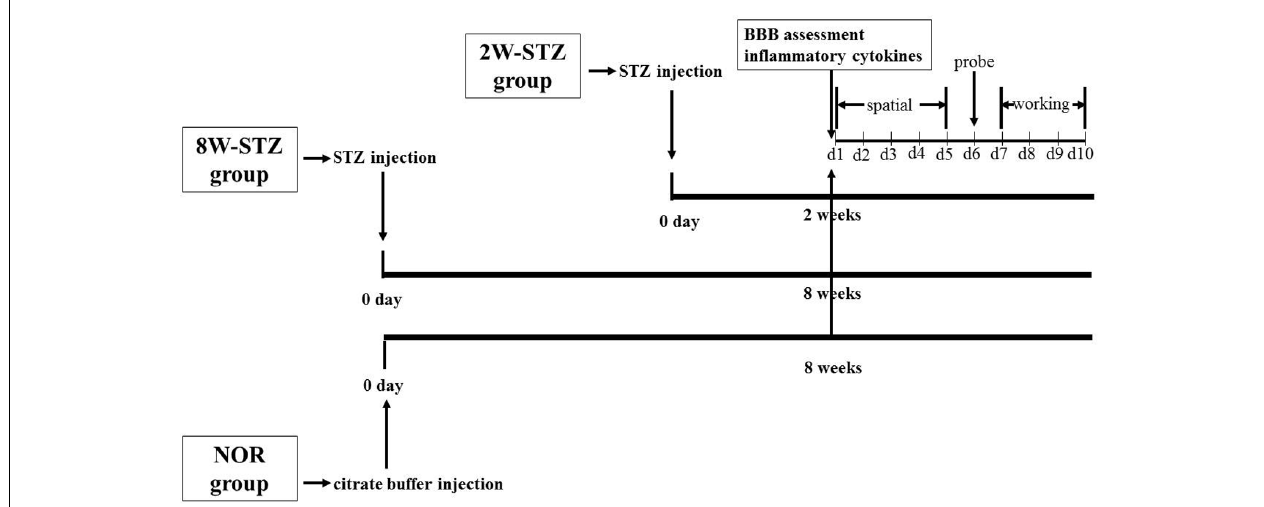
FIGURE 1 | Experimental design. Diabetic models were induced by single injection of streptozotocin on day 0. In the 2-week STZ group, the cognitive assessments were started at 2 weeks after STZ injection. The spatial acquisition trials over the first five consecutive days were followed by probe test on day 6 and working memory test from day 7 to day 10. In the 8-week STZ group, the same cognitive assessments were started at 8 weeks after STZ injection. BBB integrity and inflammatory cytokines were measured at 2 and 8 weeks after STZ injection, respectively. Rats in the normal group were conducted above experiments at 8 weeks after injection of sodium citrate buffer. NOR, normal rats; 2W-STZ, 2-week STZ; 8W-STZ, 8-week STZ. BBB, blood brain barrier; spatial, spatial acquisition trials; probe, probe test; working, working memory test.